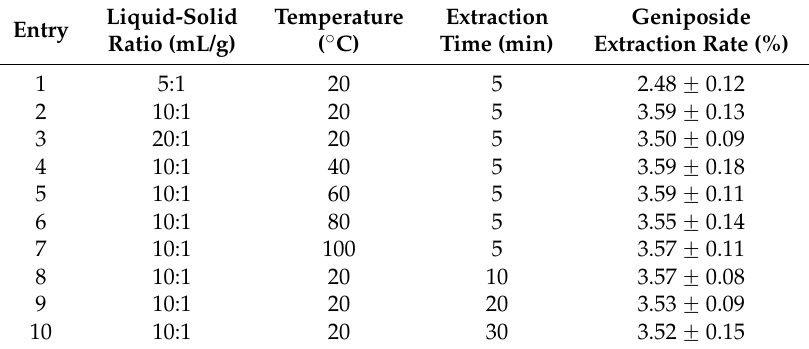
Table 2. The influence of extraction conditions on yield of geniposide in water a